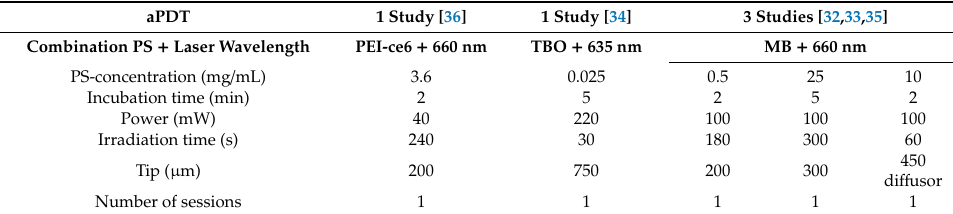
Table 6. Parameters used in antimicrobial photodynamic therapy (aPDT) in endodontics.